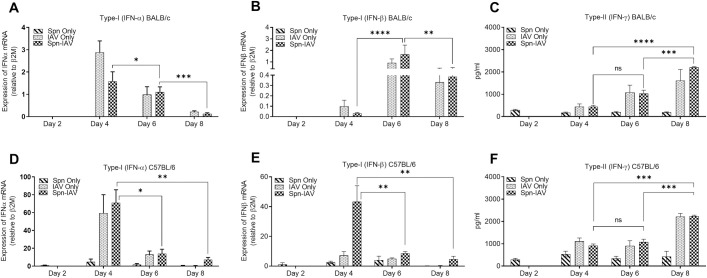
Expression of type-I and type-II IFNs in pneumococcal-influenza virus superinfected mice.BALB/c and C57BL/6 mice were infected with S. pneumoniae on Day 0 and IAV H1N1 CA04 on Day 2 and whole lung tissue samples were collected on Days 2, 4, 6 and 8. Day 2 sampling was performed before IAV infection. Quantification of type-I IFNs was performed by RT-qPCR and type-II IFN by IFN-γ ELISA. Expression of IFN-α mRNA in BALB/c (A) and C57BL/6 (D) lung tissues on Days 2, 4, 6 and 8. Expression of IFN-β mRNA in BALB/c (B) and C57BL/6 (E) lung tissues on Days 2, 4, 6 and 8. Expression of IFN-γ in BALB/c (C) and C57BL/6 (F) BALF on Days 2, 4, 6, and 8. Data are presented as means ± SD from 4 mice/group. Statistical analyses were performed by two-way ANOVA. P>0.05; *P<0.05; **P<0.01, ***P<0.001.